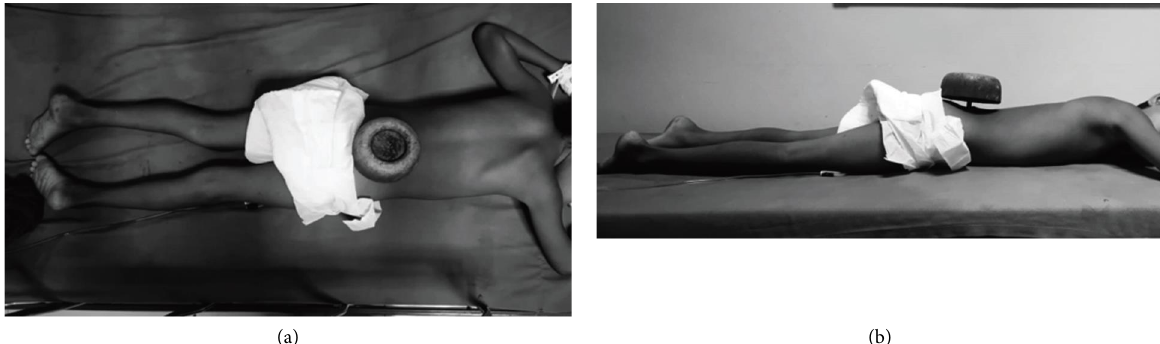
Figure 1: Above view (a) and side view (b) of the patient lying face down with a toy car wheel on an axle impaled on the lower lumbar region.